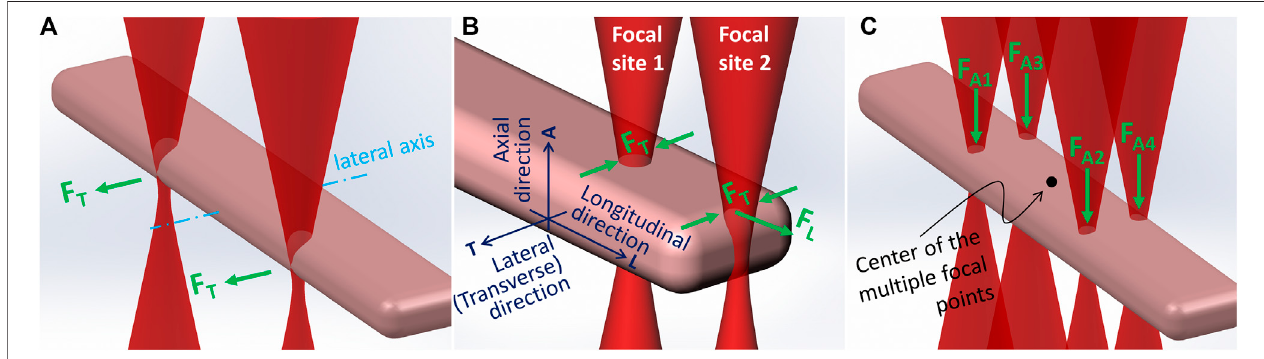
FIGURE 2 | Con fi gurations of the multiple laser beams and the major optical forces